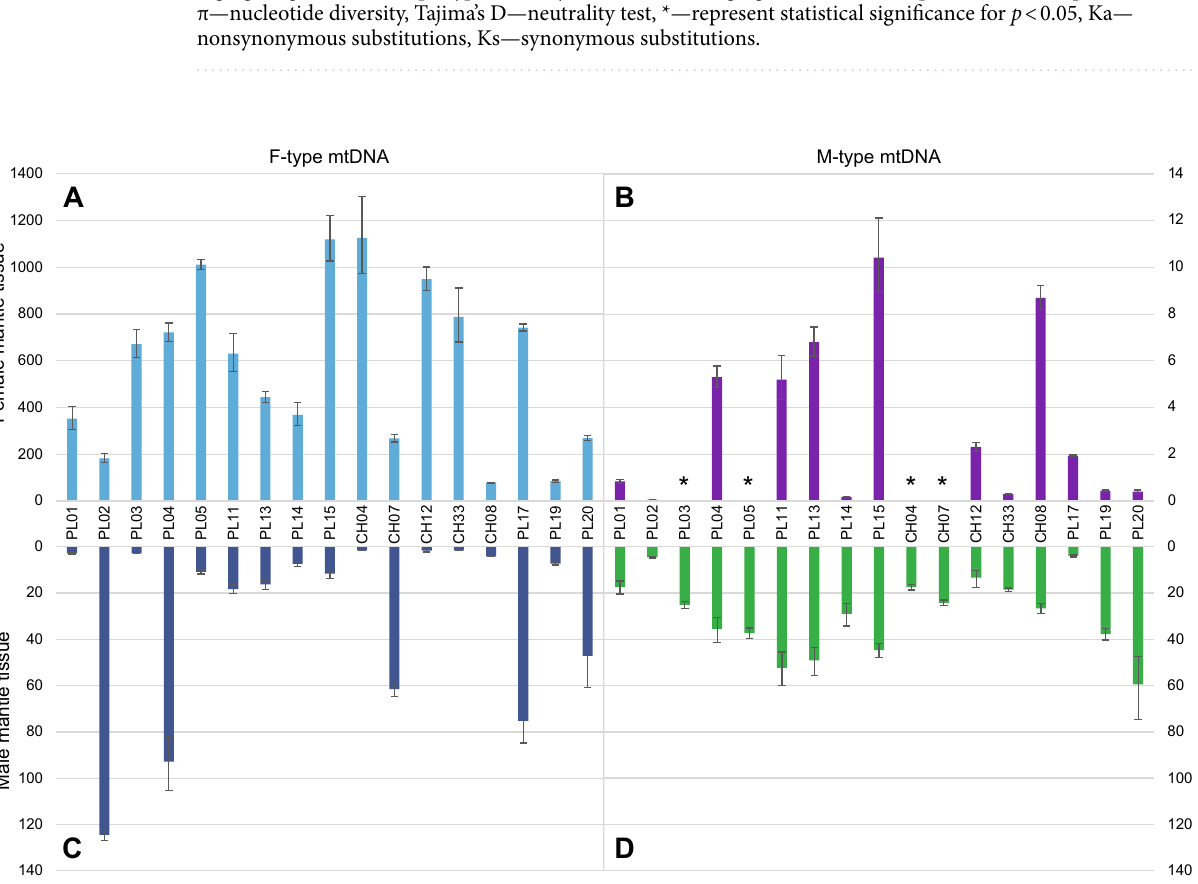
Figure 4. Number of mitochondrial genomes (F cox1 and M nad1 ) in relation to copies of nuclear DNA ( atpα ). A. F mtDNA to nuclear DNA ratio in the Female mantle; B. M mtDNA to nuclear DNA ratio in the Female mantle; C. F mtDNA to nuclear DNA ratio in the Male mantle; D. M mtDNA to nuclear DNA ratio in theMale mantle. * asterisks show samples where the M mtDNA copy number approaches